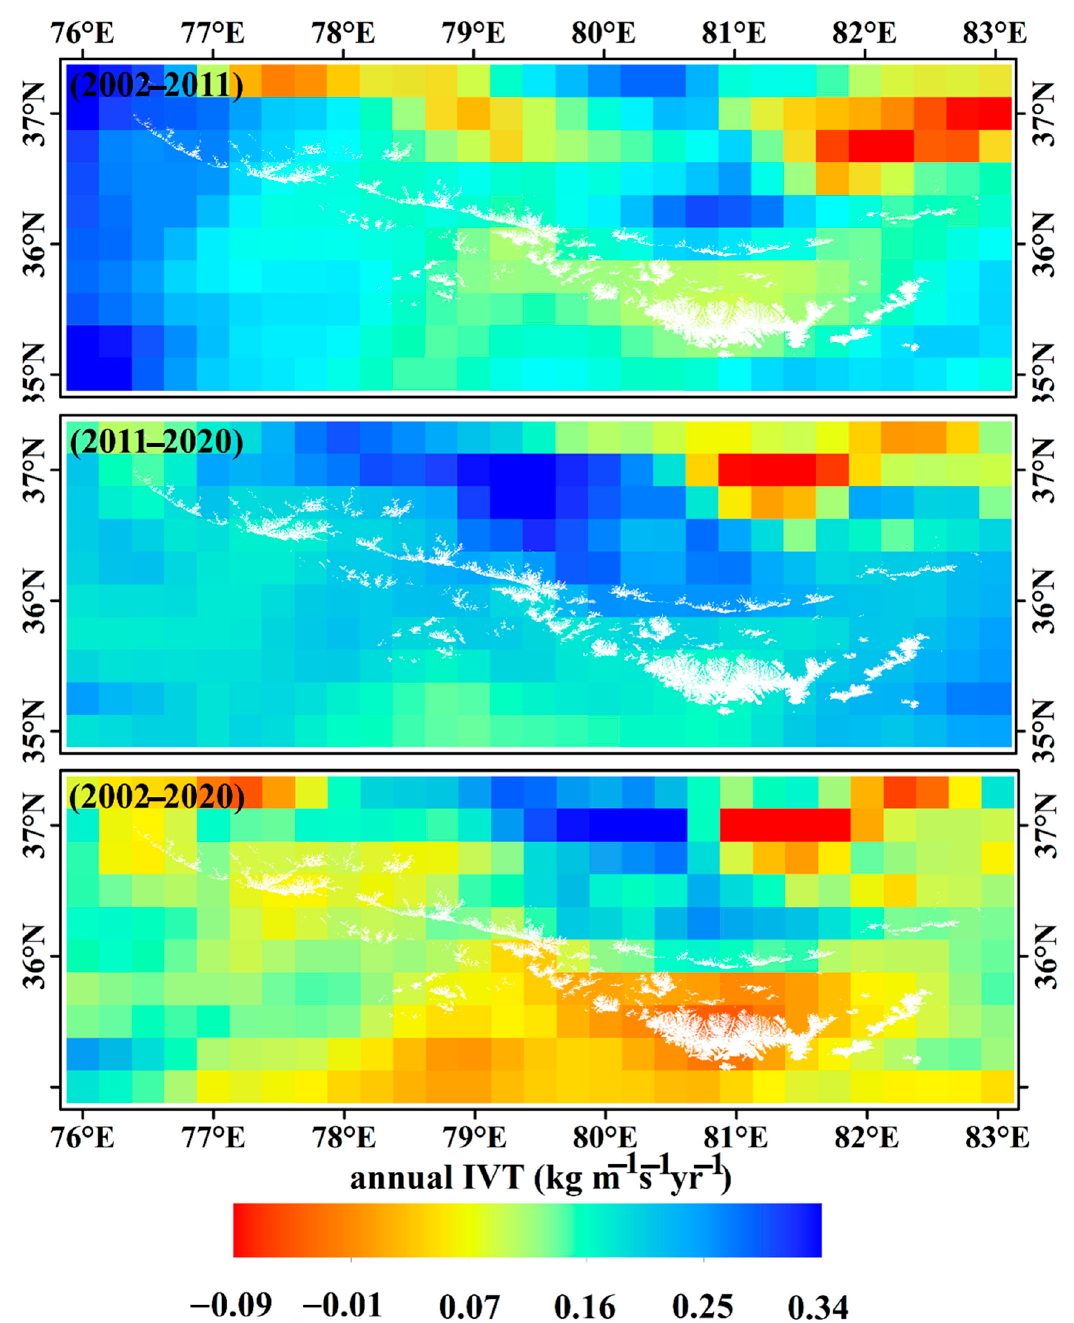
Figure 8. Annual mean integrated water vapor transport (IVT) trends in WK for 2002–2011, 2011–